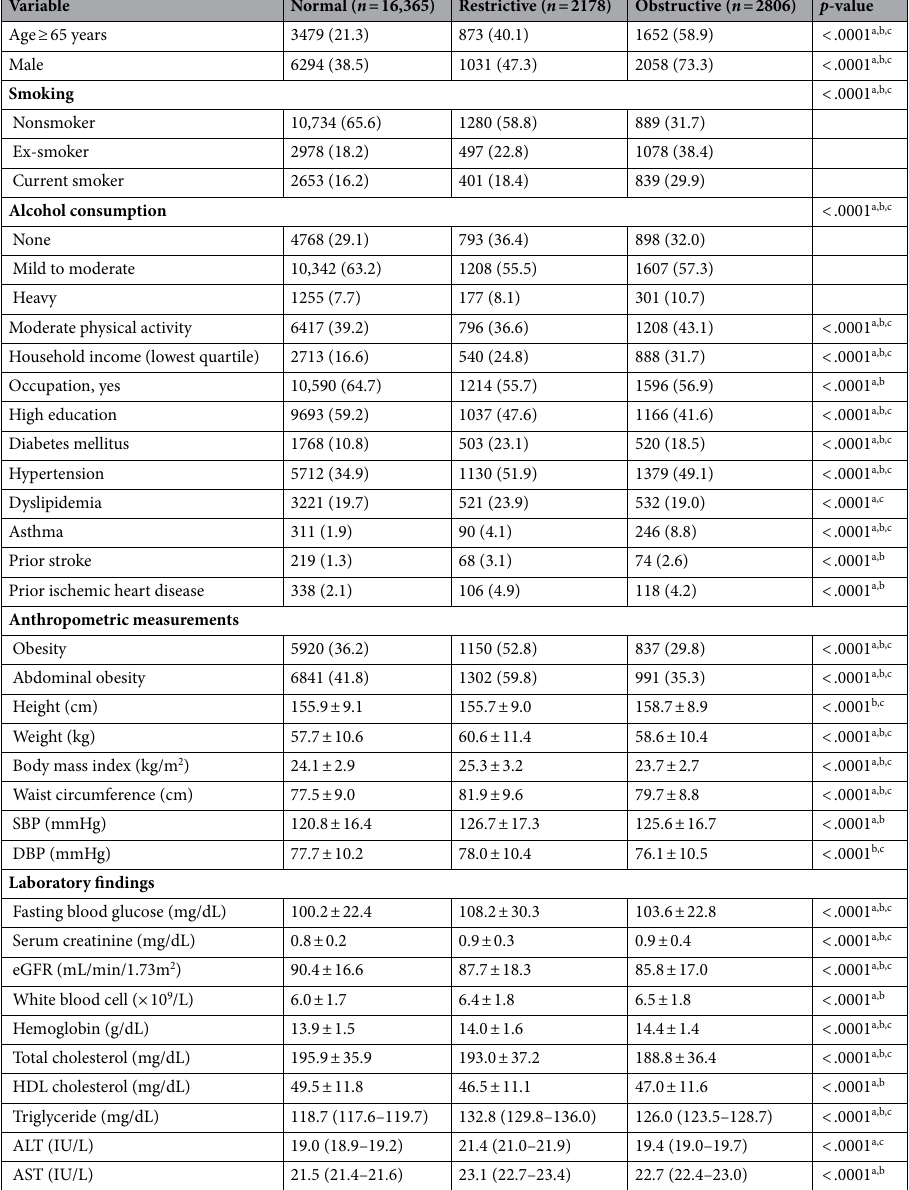
rate; HDL, high density lipoprotein; AST, aspartate transaminase; ALT, alanine transaminase. a Significant for Normal vs Restrictive, b significant for Normal vs Obstructive, c significant for Restrictive vs